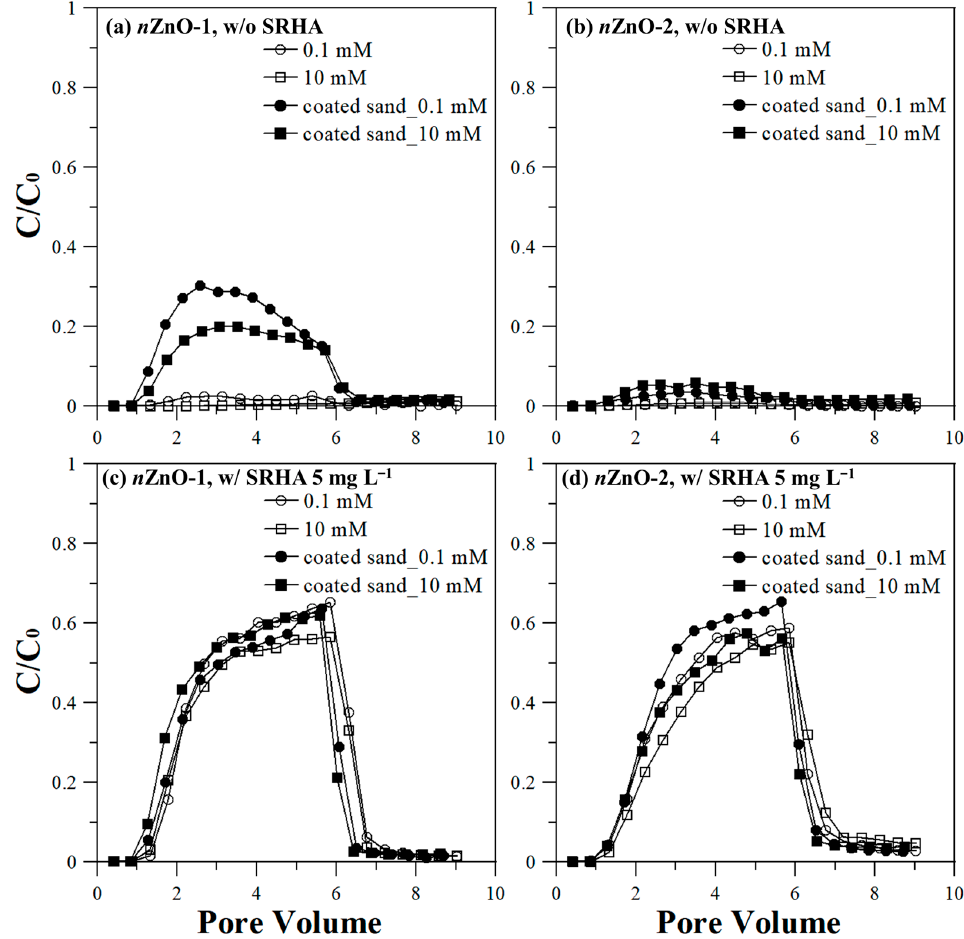
Figure 6. Breakthrough curves of n ZnO-1 and n ZnO-2 in the absence ( a , b ) and presence ( c , d ) of suspended SRHA (5 mg L − 1 ) and in the presence (solid symbol) and absence (open symbol) of coated SRHA at difference ionic strengths in NaCl solution (0.1 and 10 mM).